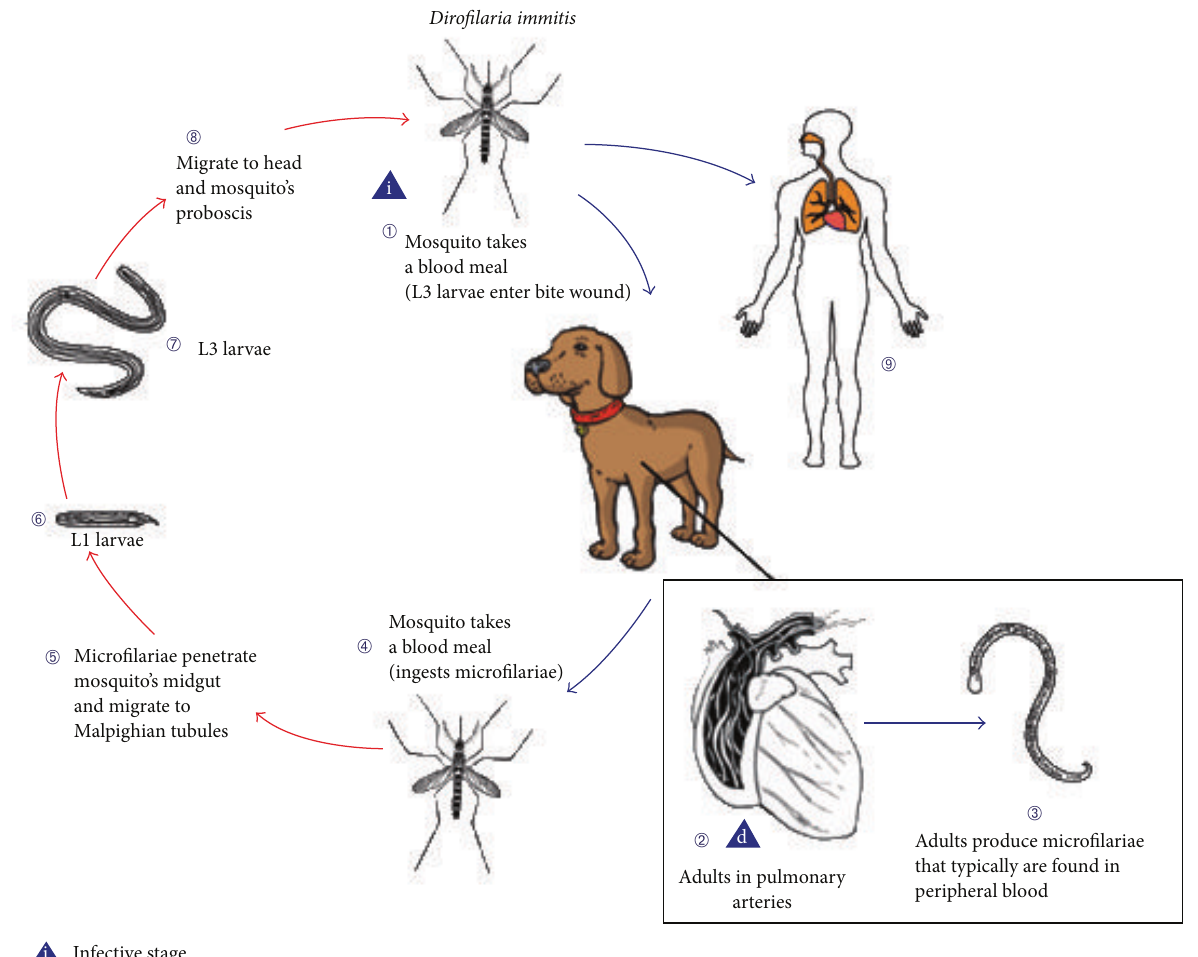
Figure 1: Biology-life cycle of D. immitis